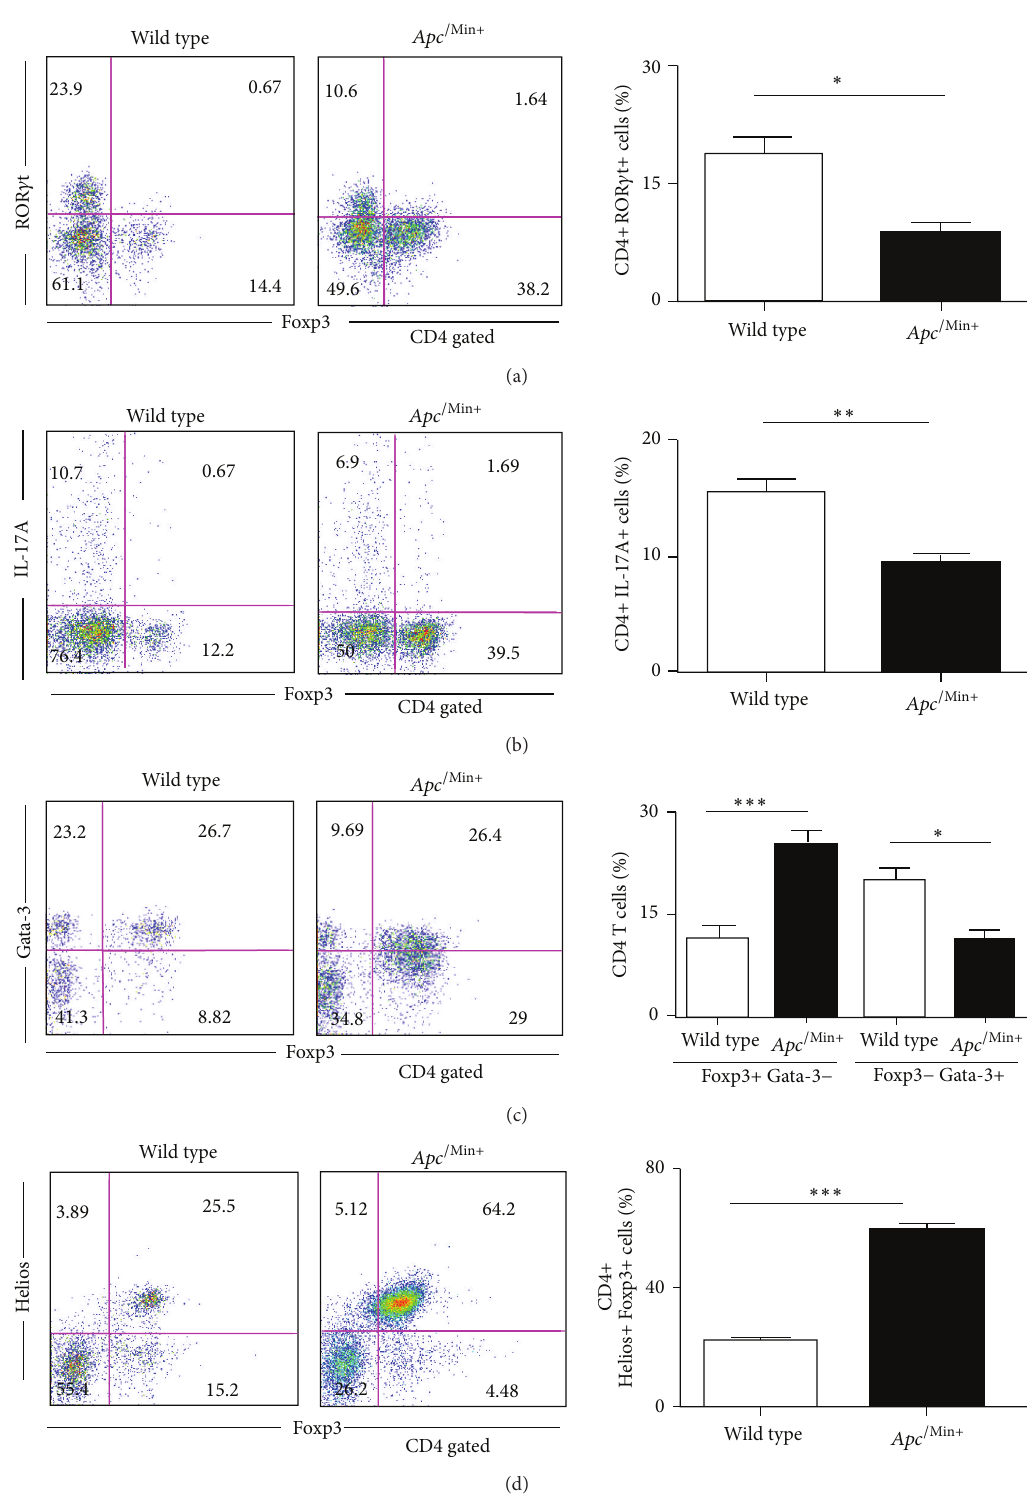
Figure 2: Th17 cells and altered Foxp3+ Tregs cells are both increased in the lamina propria of 𝐴𝑝𝑐 / Min + mice. (a–d) Four-month-old 𝐴𝑝𝑐 Min /+